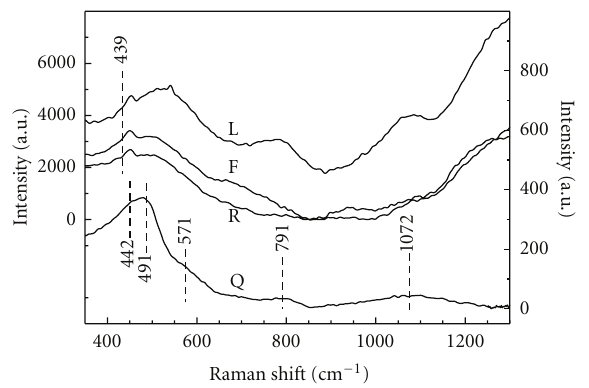
Figure 6: Raman spectra of ZnO thin films (Label L, F, R, and Q show the films on the linear moved substrate, on the fixed substrate, on the rotated substrate, and quartz substrate,